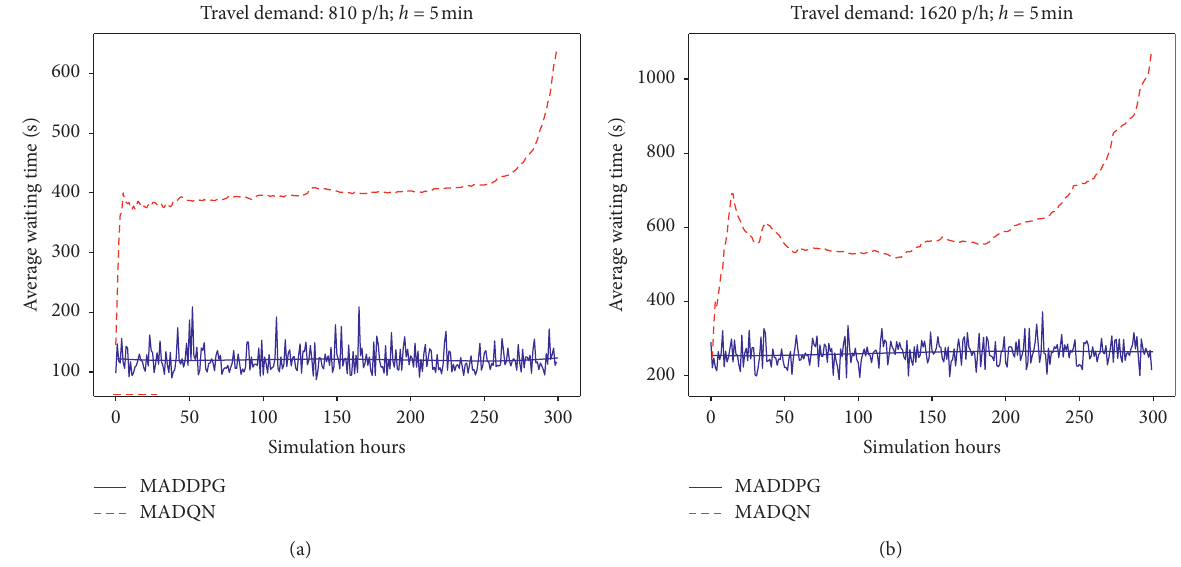
Figure 5: Performance comparison between the MADDPG and MADQN algorithms for travel demand patterns of 810 and 1620 pas- sengers/ h in a multiagent environment.